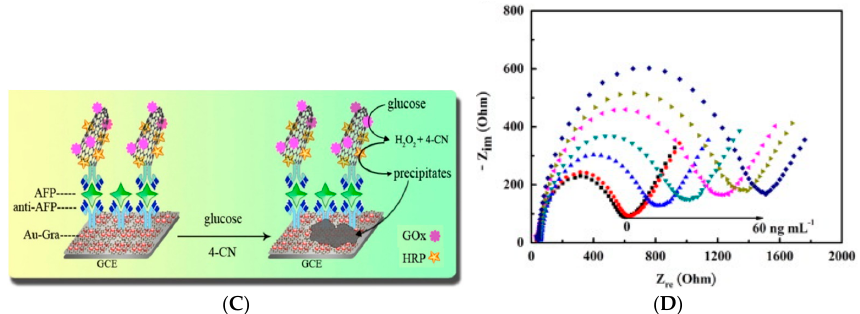
Figure 7. ( A ) Functioning of the 8-isoprostane immunosensor on a SPE; ( B ) Corresponding calibration plot for 8-isoprostane. Adapted from [45], Copyright 2016, with permission from Elsevier; ( C ) Schematic representation of electrode modification by the nanohorns–bienzyme–Ab 2 complex, for AFP detection; ( D ) Nyquist diagrams of bienzyme/Ab 2 /SWCNHs bioconjugates, for various AFP concentrations. Adapted from [46], Copyright 2014, with permission from Elsevier.